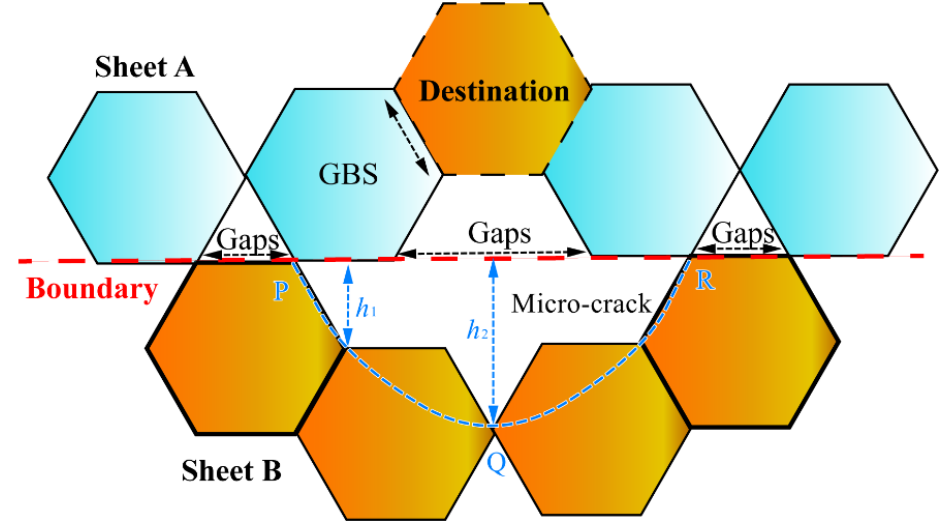
Figure 8. The mechanisms of micro-cracks during the DB process of titanium alloy.